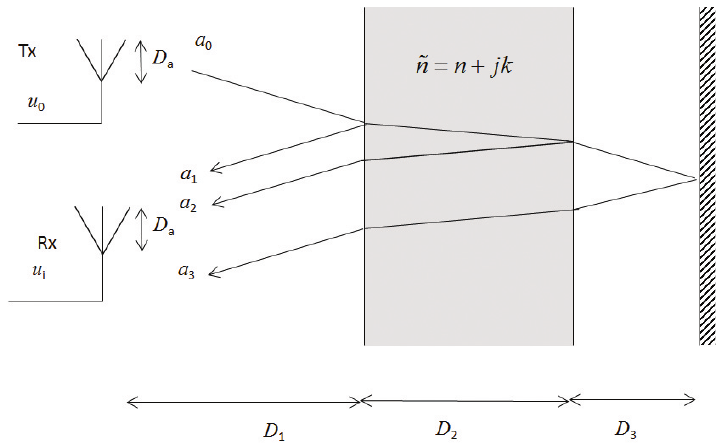
Figure 1. The geometry of the experiment for determining the time delay of the reflected pulse. Tx and Rx are the transmit and receive antenna. D 1 , D 2 , and D 3 are the distances between the antennas and the reflecting interfaces; a 0 is the pulse emitted from the Tx antenna, and a 1 , a 2 , and a 3 are the pulses from the first reflections in the respective interfaces and reach the receive antenna. u 0 is the reference pulse, and u i (i = 1, 2, 3, ..., r) represents the recorded pulses. The object’s refractive index is ˜ n = n + jk . At D 3 , there is a reference object.